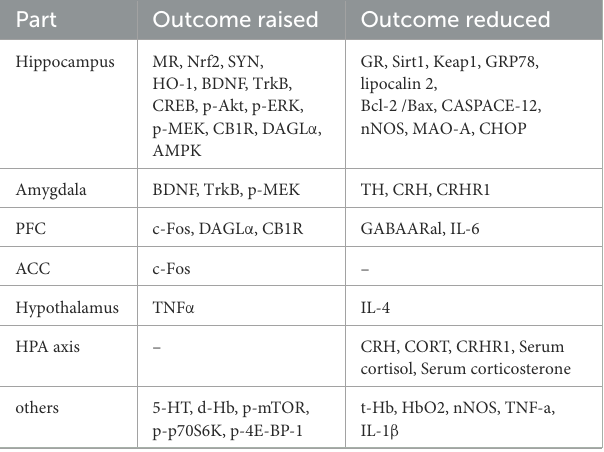
TABLE 1 Effects of acupuncture on various parts of PTSD model